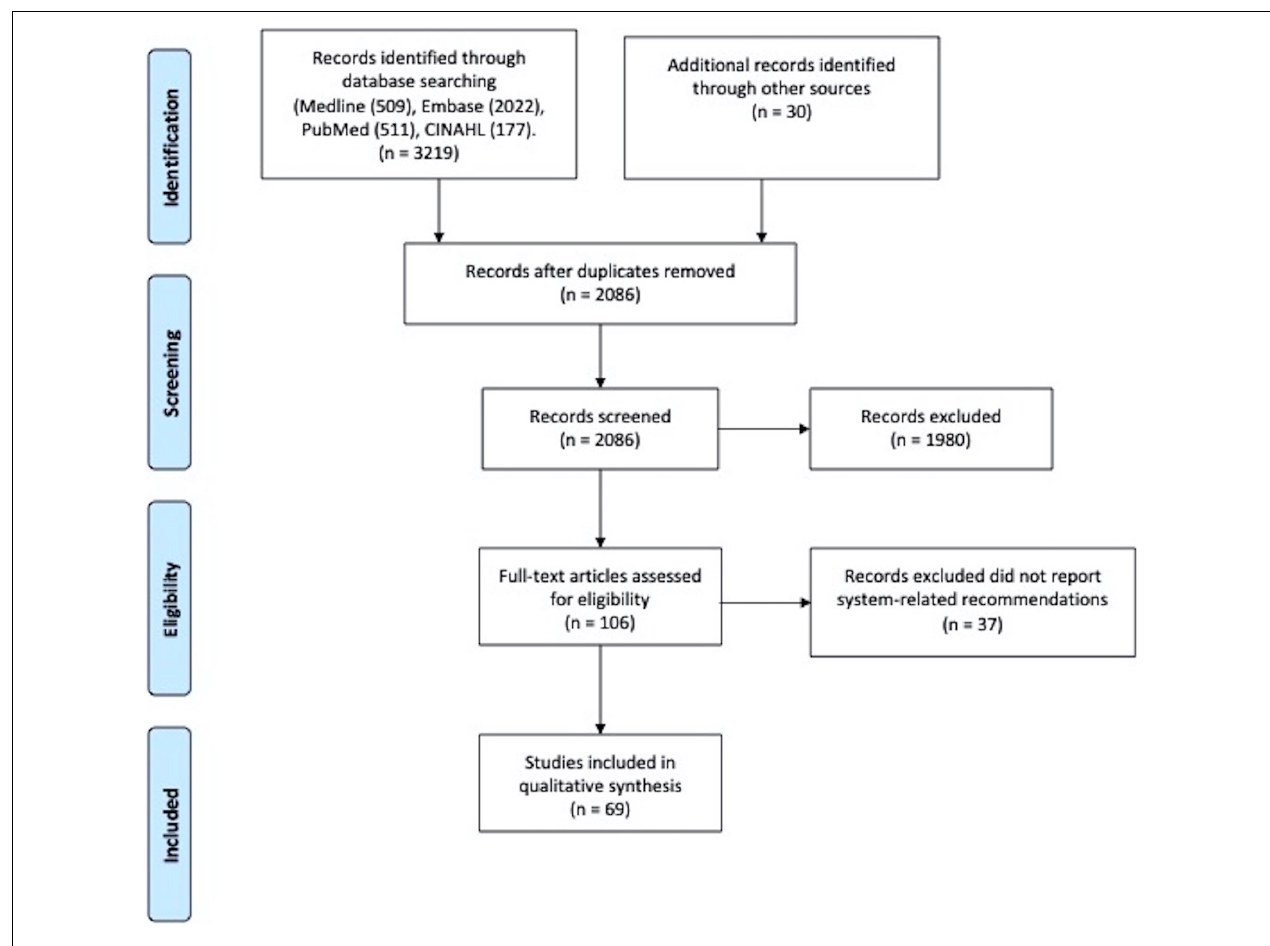
FIGURE 2 | PRISMA flow diagram.